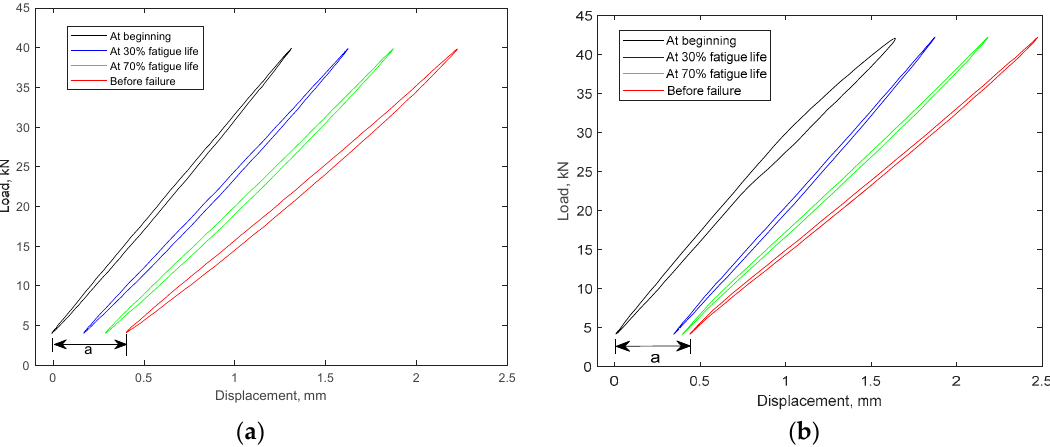
Figure 7. Hysteresis loop during the fatigue test at the beginning, 30% fatigue life, 70% fatigue life and before failure for ( a ) inter-ply ( b ) intra-ply hybrid composites.